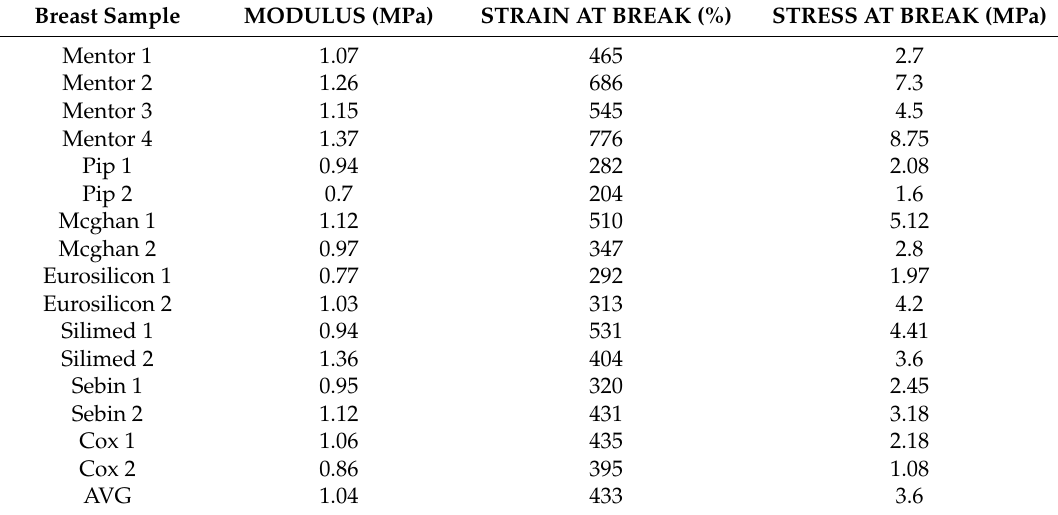
Table 3. Results of mechanical tests for all samples: Young’s modulus; stress at break; strain at break. Breast Sample MODULUS (MPa) STRAIN AT BREAK (%) STRESS AT BREAK